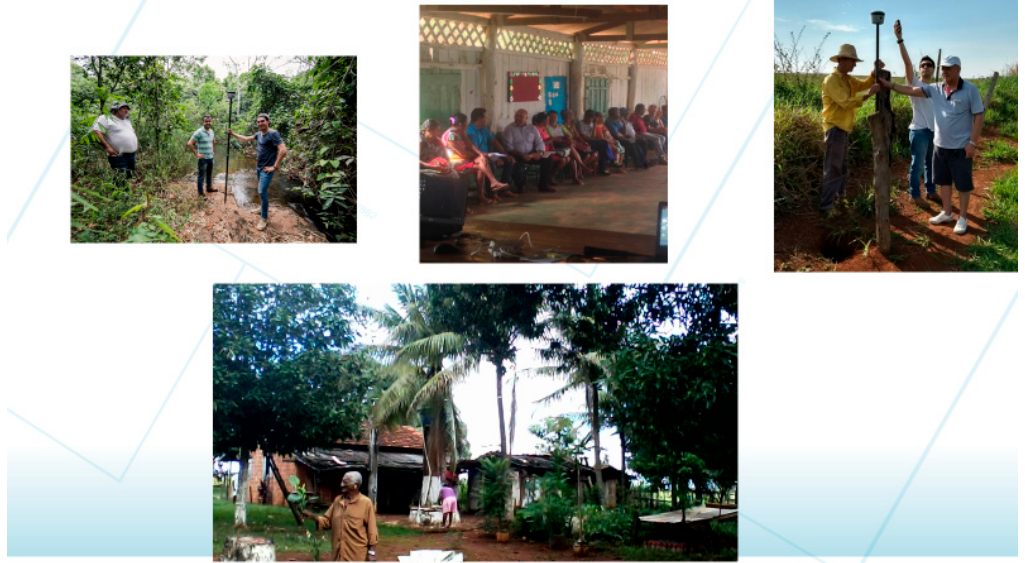
Figure 4. Images from the pilot case in Tangará da Serra.